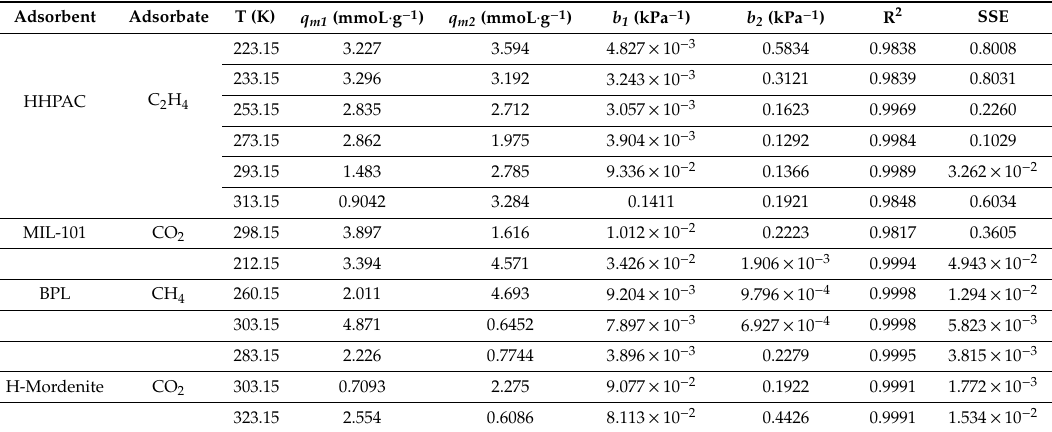
Table 7. The dual-site Langmuir (DSL) model parameters and errors for di ff erent systems at di ff erent